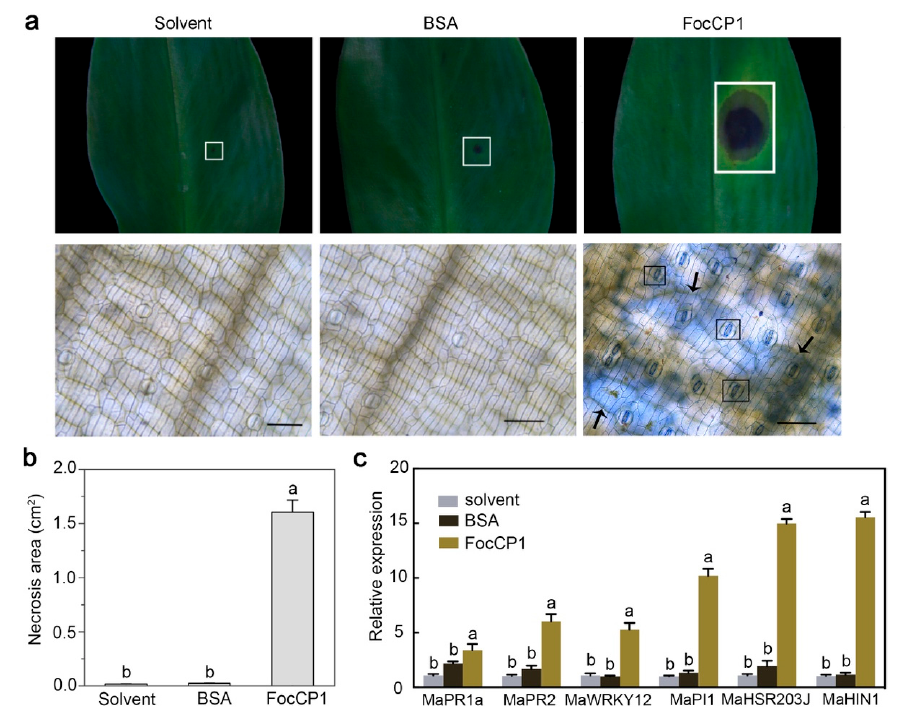
Figure 5. Biological function of FocCP1. ( a ) Banana leaves were treated with solvent, 50 µM BSA, or 50 µM FocCP1 protein for 48 h and cell death was observed using Trypan blue staining, the death of the stomata guard cells (black frames), and of epidermal cells (black arrows). Bars = 100 µm. ( b ) Areas of necrosis were measured on 8 leaves of 4 plants. Data are presented as means ± SDs and